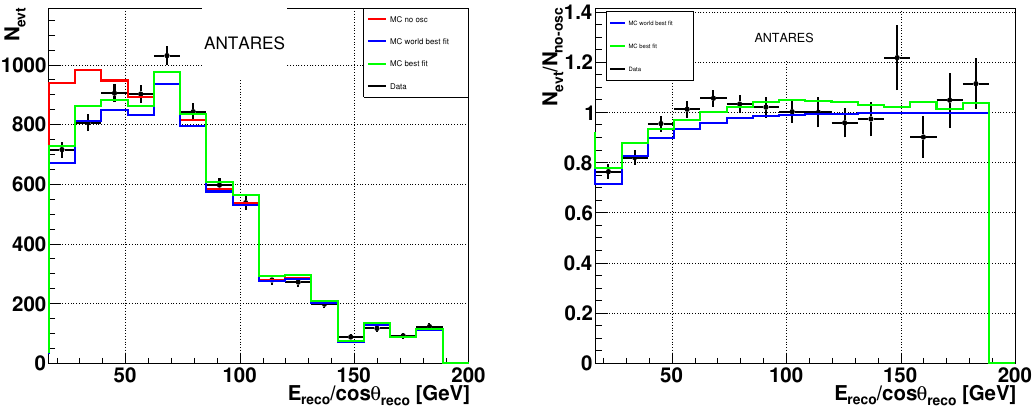
Figure 6 . E reco = cos (cid:18) reco distribution for data (black), MC without oscillation (red), MC assuming the world best-(cid:12)t values (blue) [38] and MC assuming best-(cid:12)t values of this analysis (green). The left plot shows event numbers while the right plot illustrates the event ratio with respect to the MC without